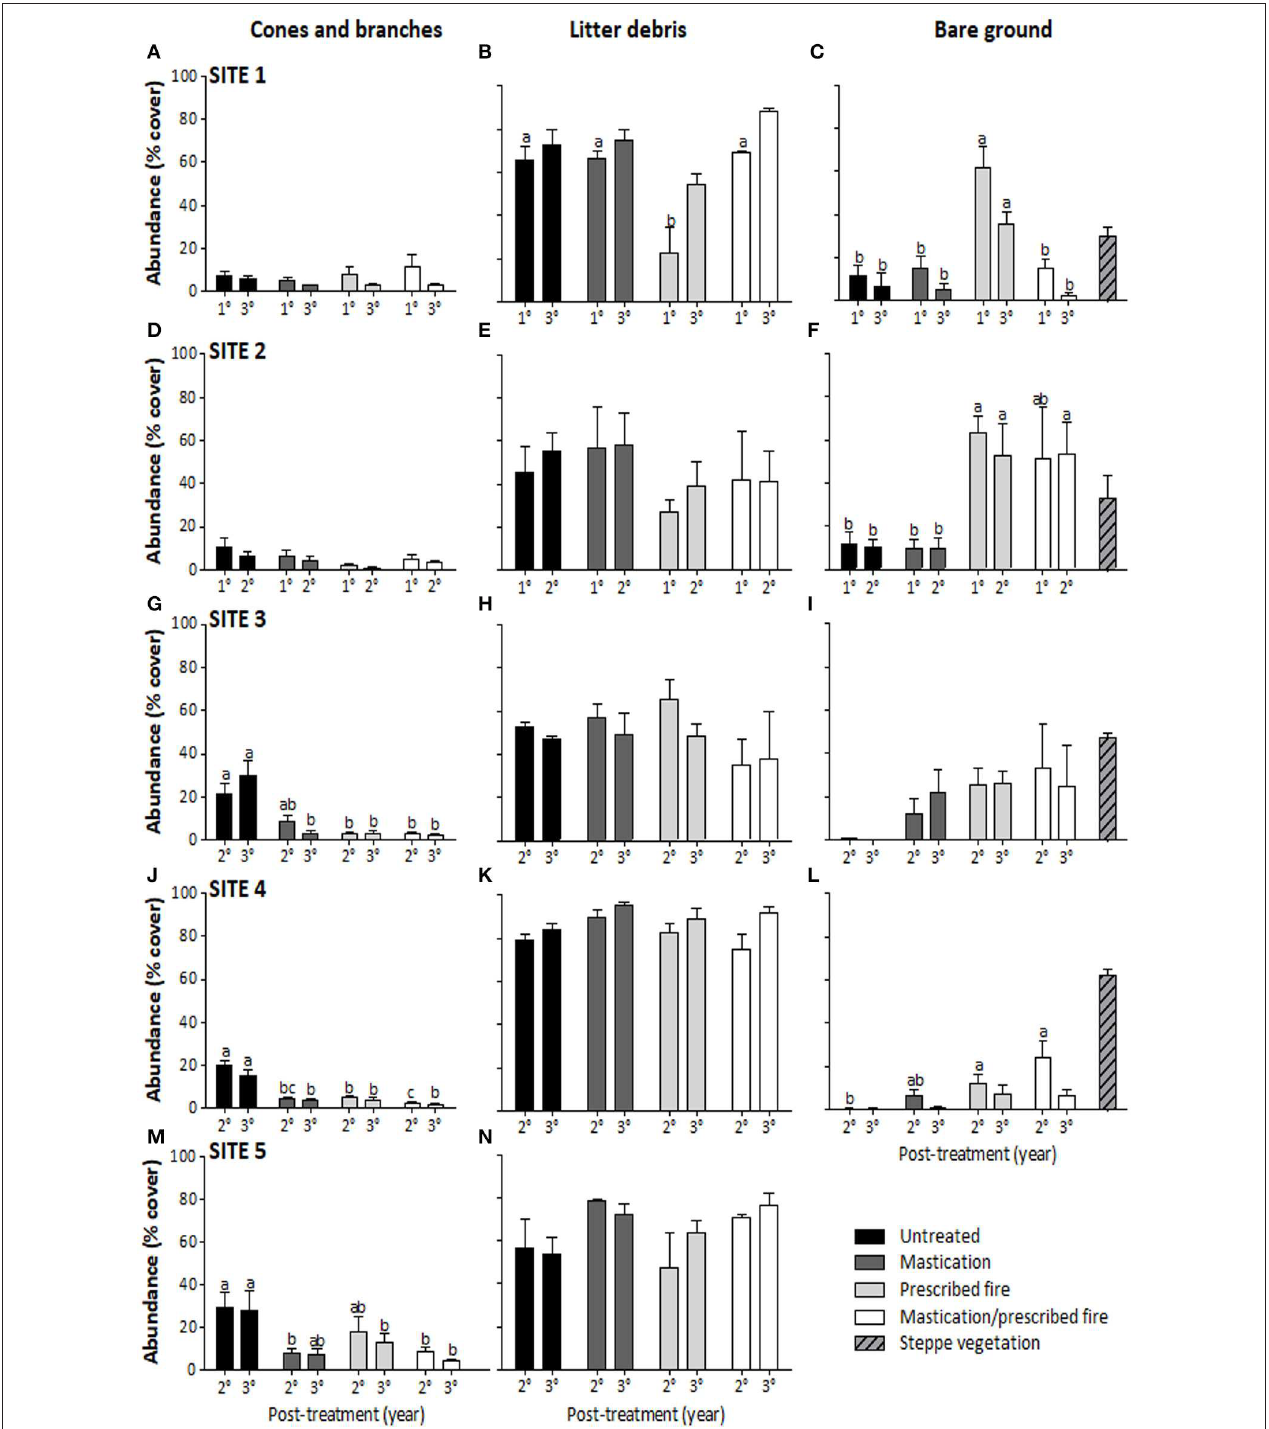
FIGURE 11 | Cones and branches (A,D,G,J,M) , litter debris (B,E,H,K,N) , and bare ground (C,F,I,L) cover in 2 years of sampling for each fuel treatment in sites 1 (A–C) , 2 (D–F) , 3 (G–I) , 4 (J–L) , and 5 (M,N) . Bars indicate SE , and letters indicate significant differences ( p < 0.05) among fuel treatments. Native species usually remain constant after fuel reduction negative short-term impact on vegetation. This treatment, treatments, whereas exotics commonly increase in those compared with UNTREATED, has the plus that may reduce treatments involving fire (Abella and Springer, 2015). However, fire hazard.